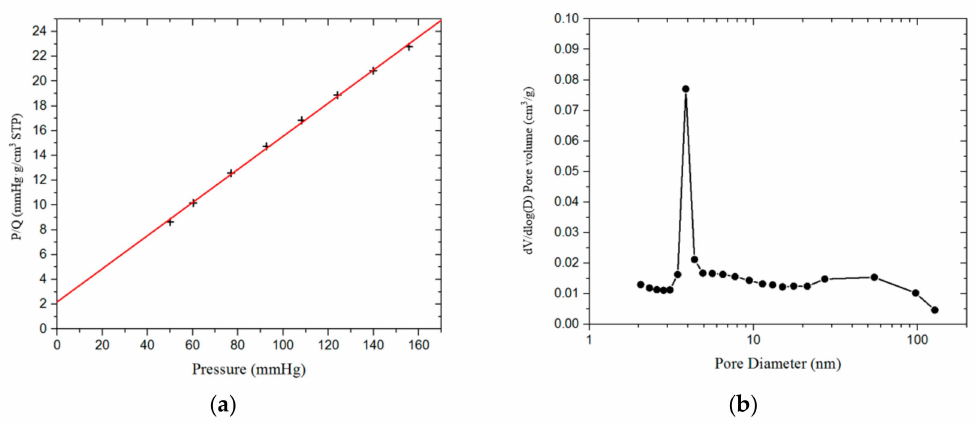
Figure A5. Nitrogen adsorption of sample 3 measured by an ASAP 2420 instrument (Micromeritics). ( a ) Langmuir surface area plot; ( b ) BJH desorption dV / dlog(D) pore volume.